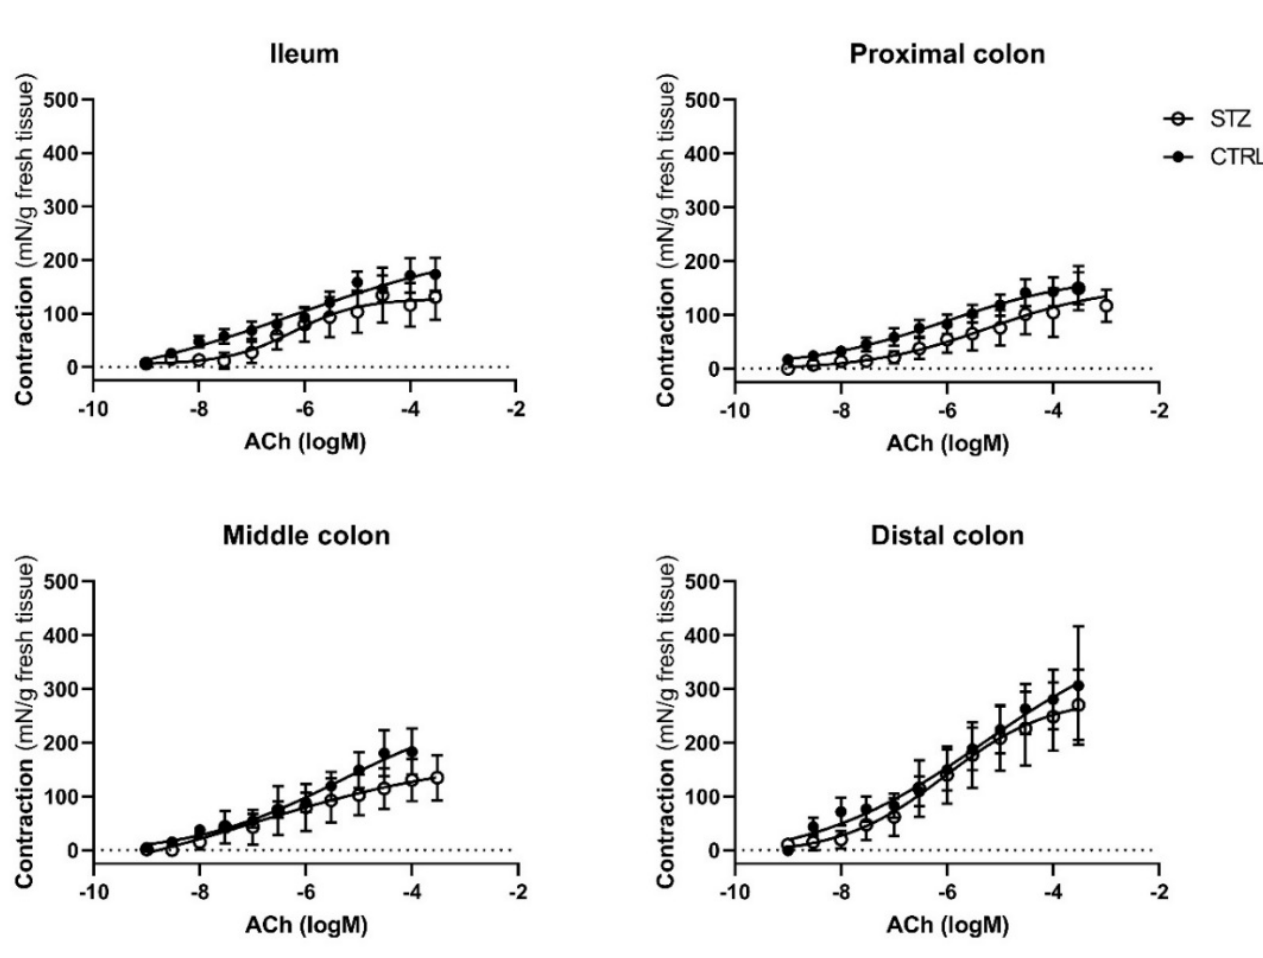
Figure 6. Concentration-response curves to ACh in the ileum, proximal colon, middle colon and distal colon of control (CTRL, n = 6–7) and streptozotocin-induced diabetic rats (STZ, n = 10). Data are expressed as mN of force per g of fresh tissue (mN/g). Values are mean ±